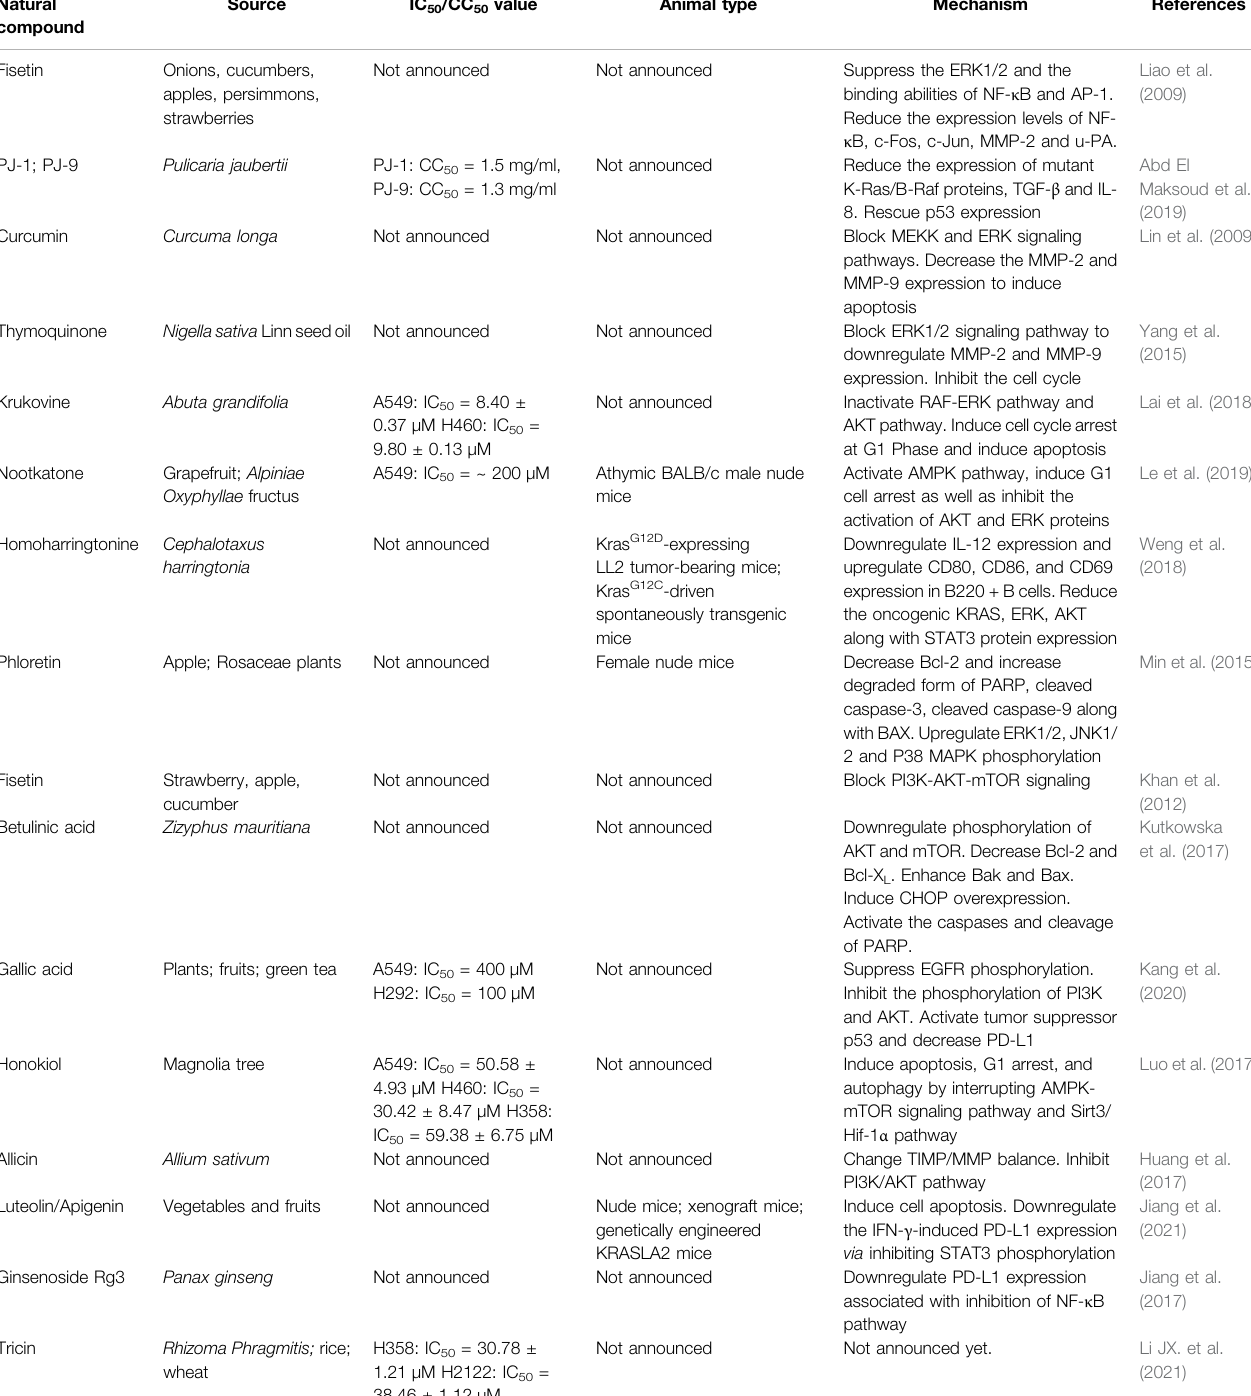
TABLE 3 | Mechanisms of natural compounds in treating KRAS-mutant NSCLC. Natural